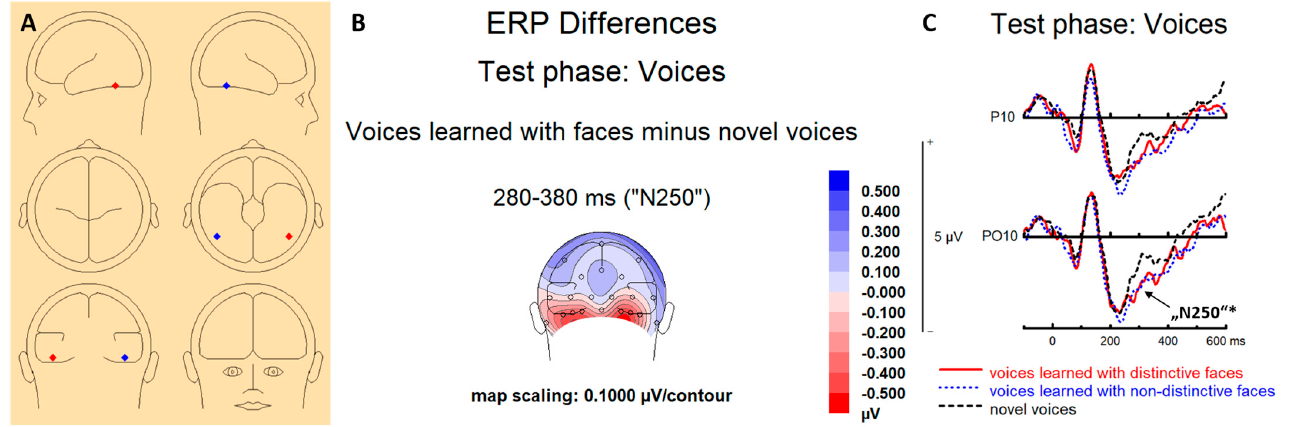
Figure 5. ( A ) Source localization for the “N250” to test voices (difference between voices learned with faces vs. novel voices). ( B ) Topographical voltage map of the same difference (spherical spline interpolation, 110° equidistant projection, backview) for the N250 time window. ( C ) Grand mean averages of uni-modal voice − elicited “N250” at P10 and PO10 in the test phases, for voices that had been learned with distinctive or non − distinctive faces, and for novel voices (* p < 0.05).